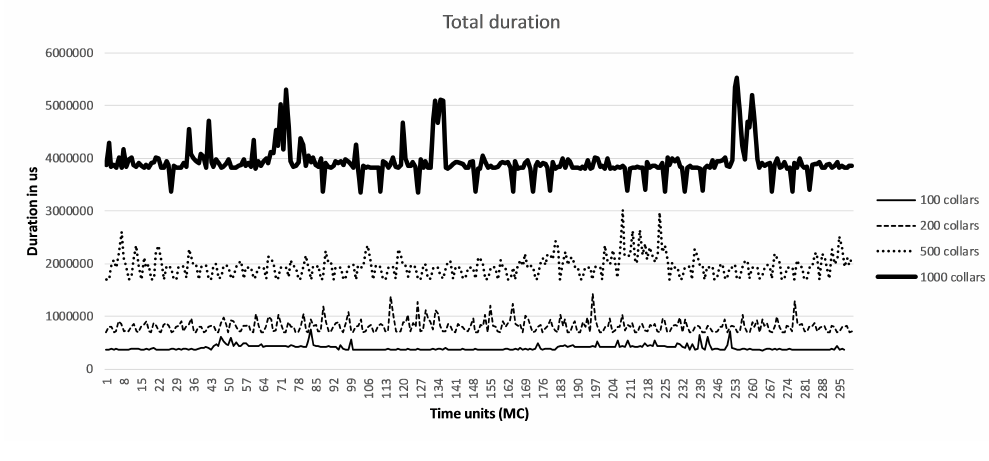
Figure 11. Cumulative processing duration. Table 4. The worst case measurements (maximum duration